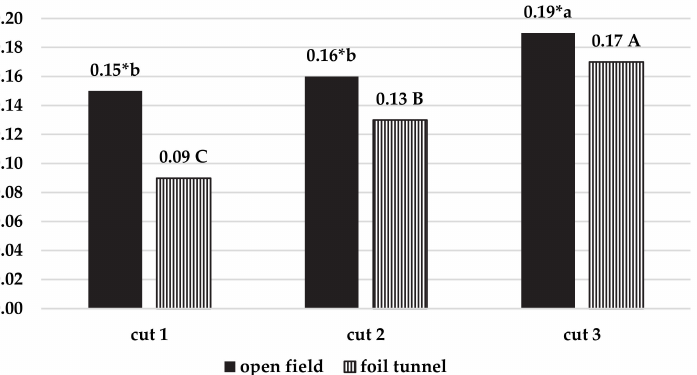
Figure 3. The total content of phenolic acids in common thyme herb (g × 100 g − 1 FW). Tukey test; * p < 0.05; a, b are the means marked with small letters (values for following cuts in the open field) differ at p < 0.05; A, B, C are the means marked with capital letters (values for following cuts in the foil tunnel) differ at p < 0.05.